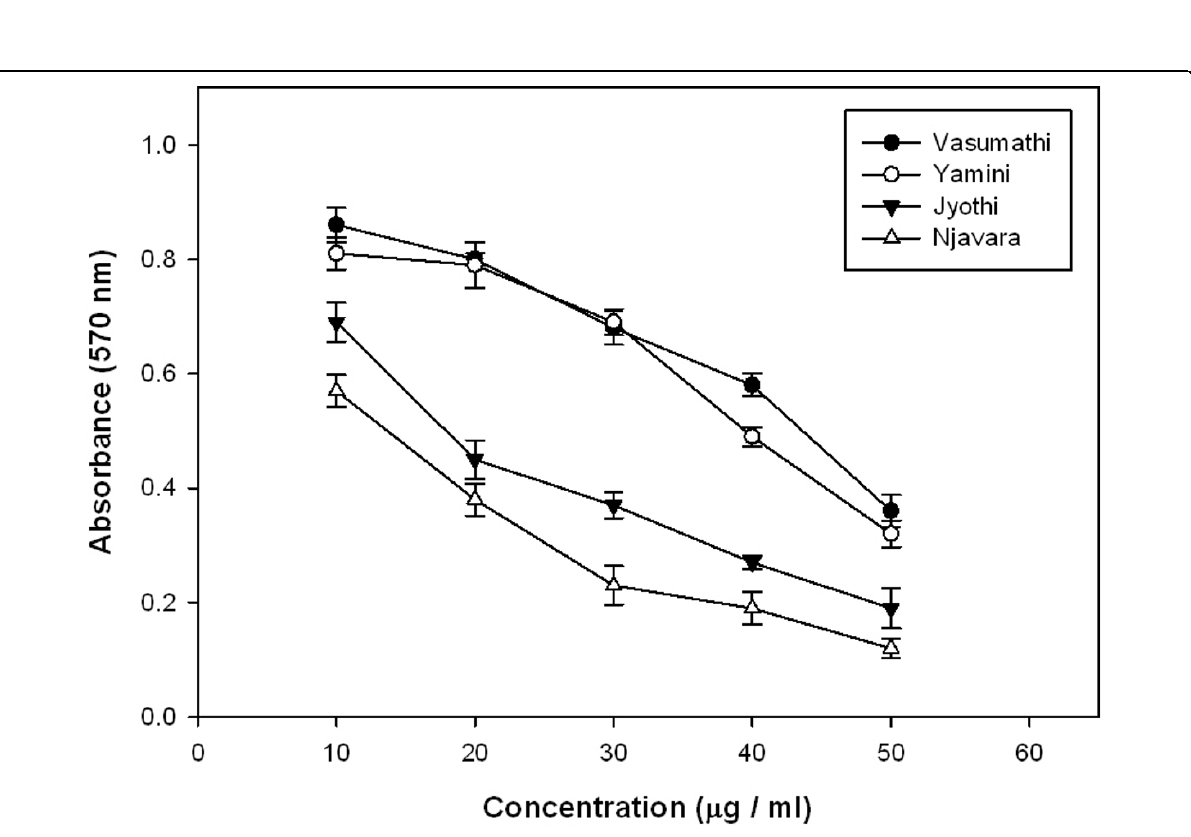
Figure 5 Cell cytotoxicity assay . MTT assay with different concentrations of methanolic rice bran extracts from four rice cultivars. Results represent means ± standard deviation (n =